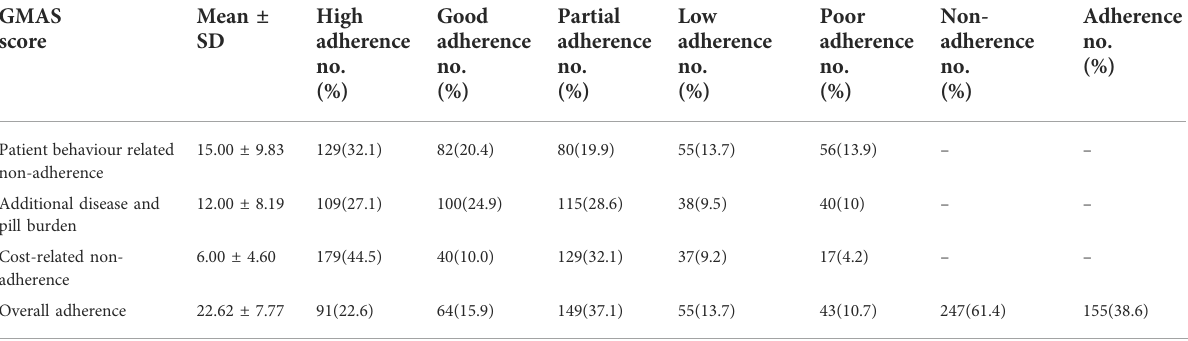
TABLE 2 Medication adherence among